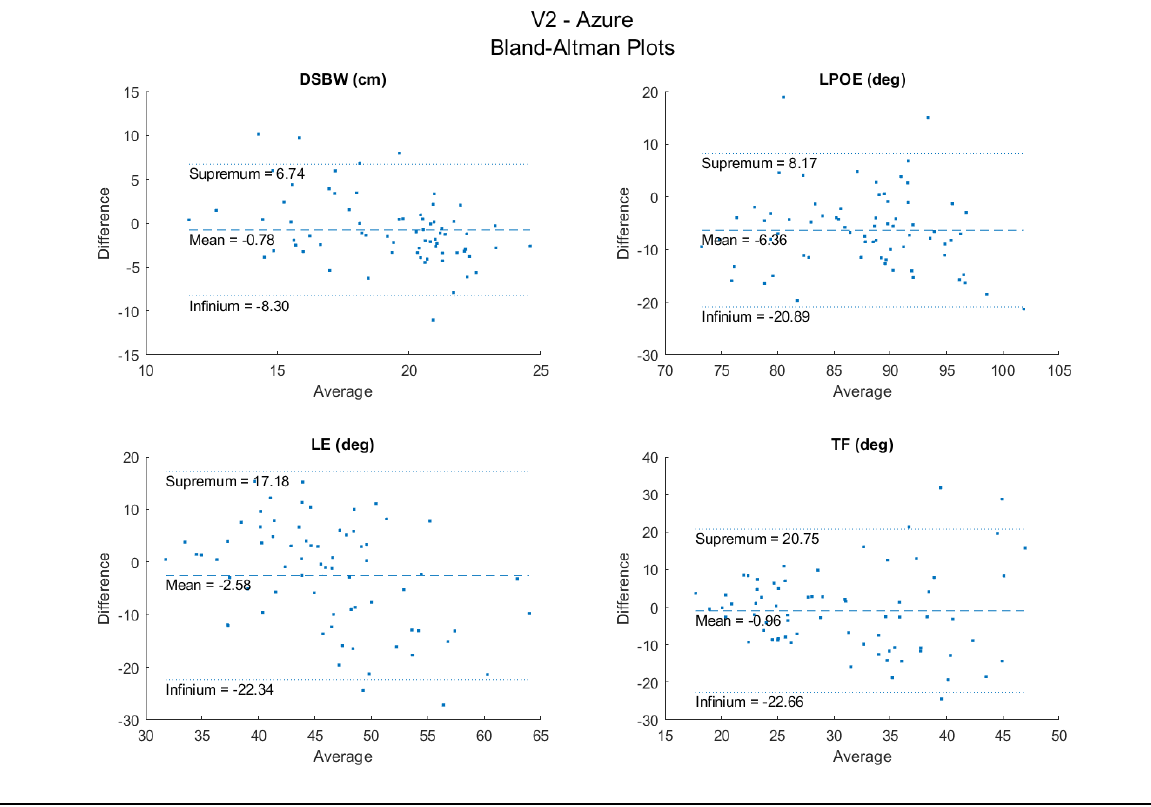
Figure 6. Bland − Altman plots between Azure and V2.